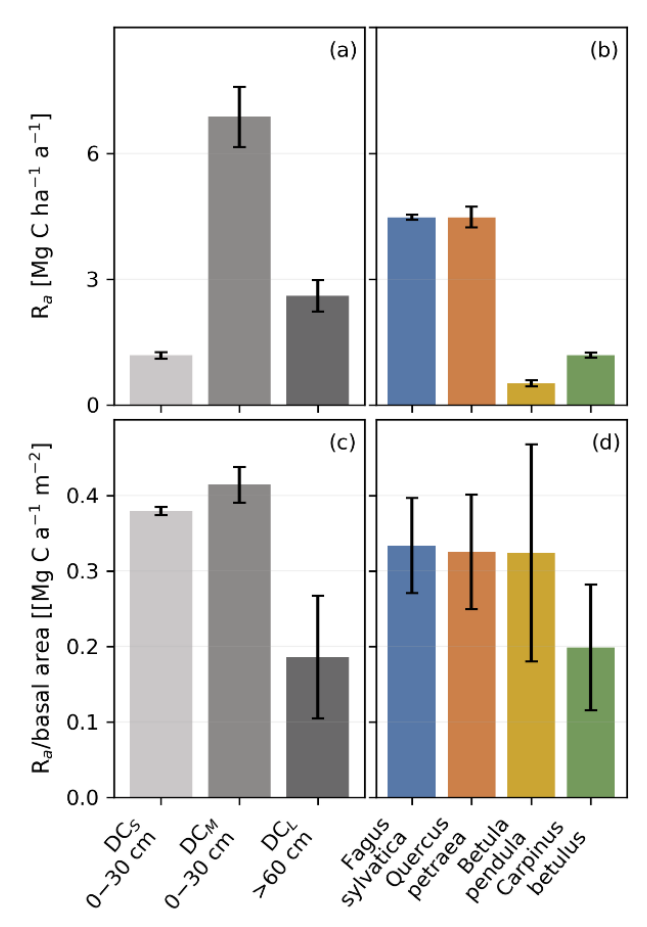
area ( c , d ) across three tree size classes and occurring Figure A3. Simulated annual mean autotrophic respiration ( R a ), as well as area respiration across three tree size classes and occurring species. The bars indicate temporal fluctuation throughout the simulation time and simulation runs. Due to the normalization of the index (values between 0.2– 0.6), the variability in c and d seems large due to small changes in R eco and basal area.